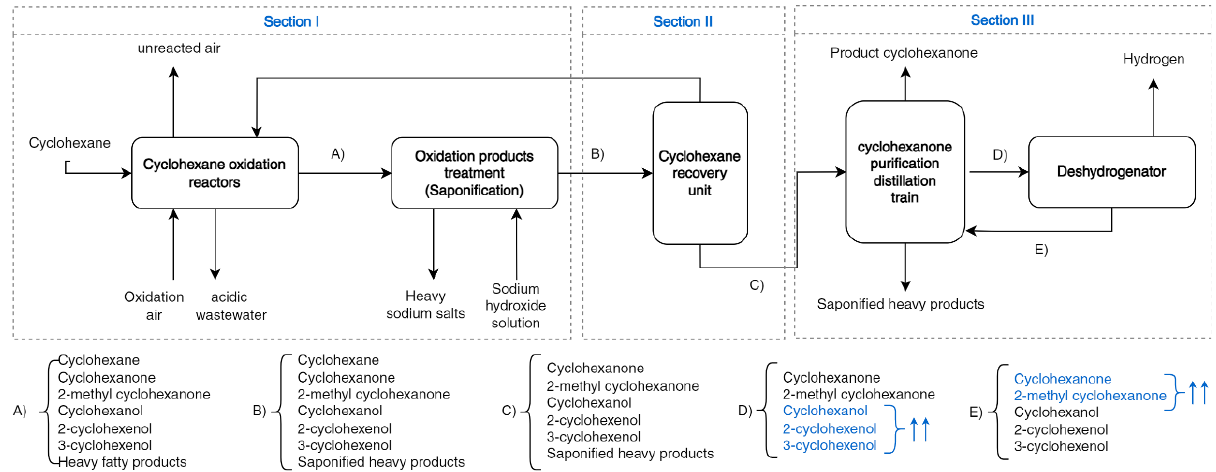
Figure 2. Simplified diagram representing the production stages of cyclohexanone, indicating some of the compounds participating in each stream. In blue, the five compounds whose separation is proposed in this work are presented.